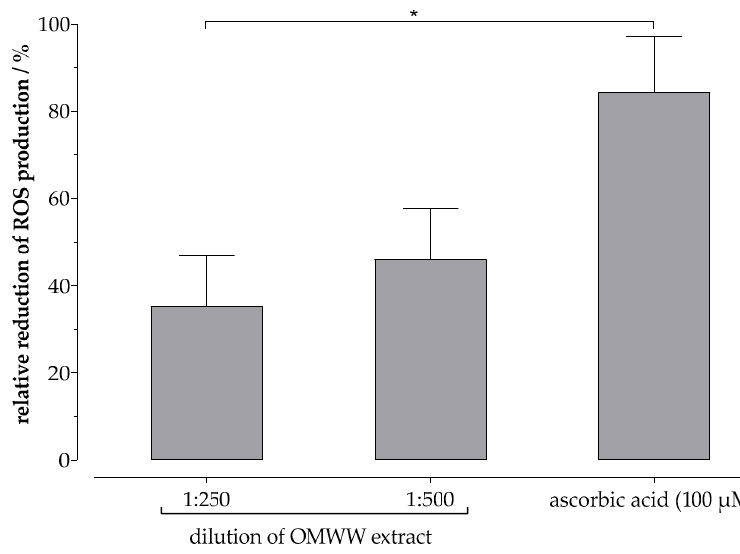
Figure 4. Treatment (30 min) of HaCaT cells with each OMWW extract dilution (1:250 and 1:500) and ascorbic acid (100 µ M) after ROS induction by H 2 O 2 (100 µ M) for 15 min; MW ± SD, n ≥ 3, * p ≤ 0.05 (with five replications). HaCaT cells, only treated with H 2 O 2 , represent 100% of the generated reactive oxygen species (ROS).